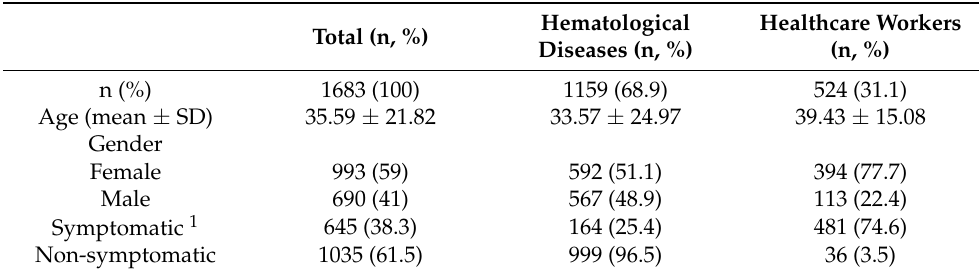
Table 1. Demographic data of the studied population. Total (n,